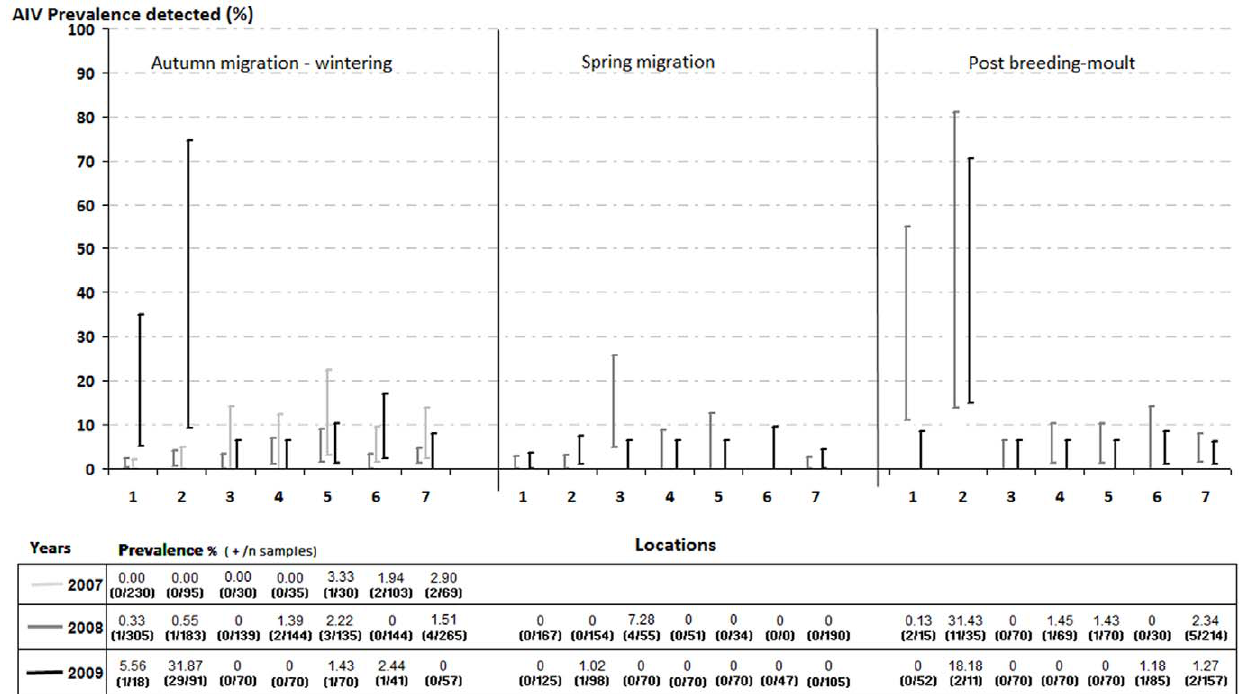
Figure 2. AIV prevalence in Spanish wetlands: variation of mean AIV prevalences by season, year and location (Bars reflect the 95% confidence interval).